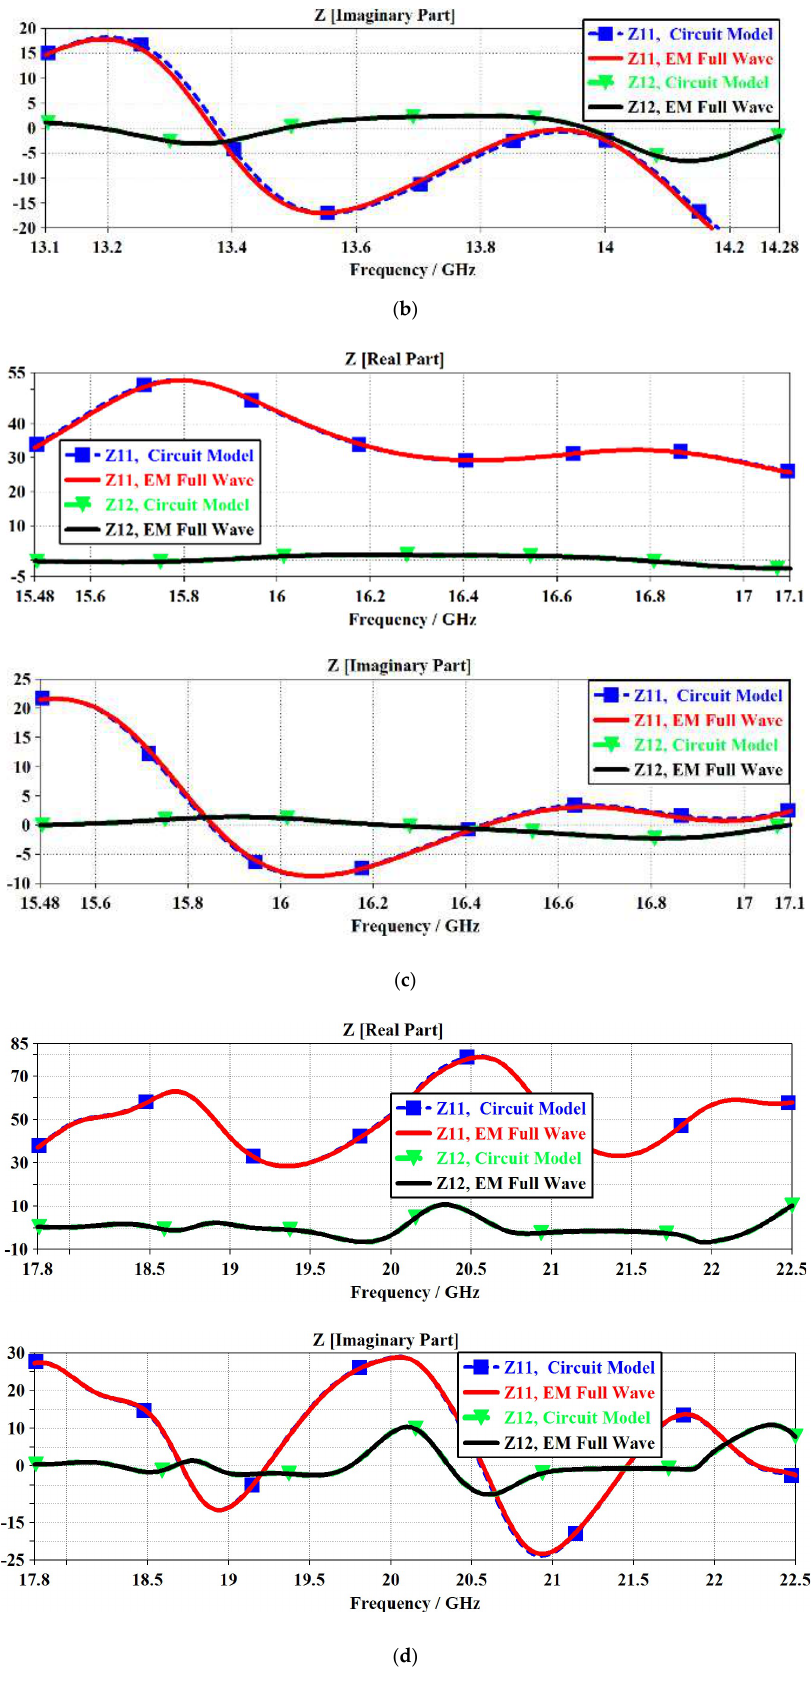
Figure 3. Input impedance (Ω) and admittance (1/Ω) of the proposed slotted array antenna. ( a ) Coverage over X-band; ( b ) Coverage over the first Ku-band; ( c ) Coverage over the second Ku-band; ( d ) Coverage over the third Ku-band and K-band.